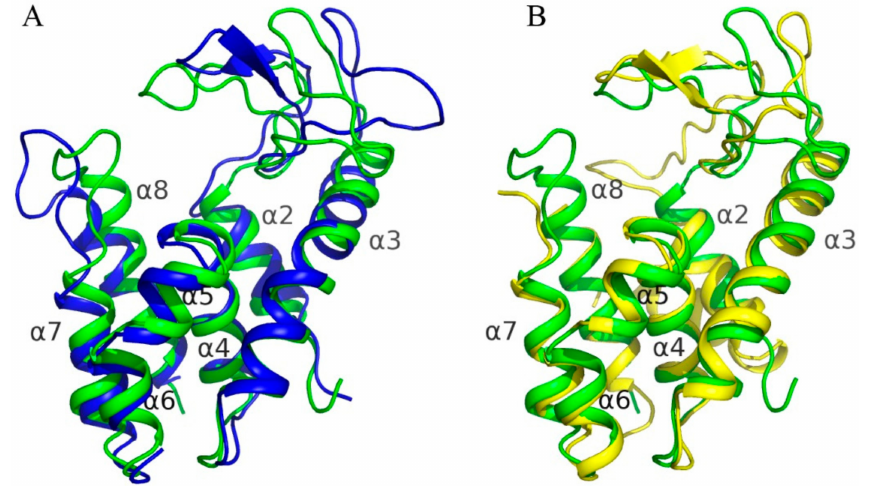
Figure 6. Superposition of AcLys to structures of homologue enzymes. AcLys is colored in green. Secondary structure elements were captioned in accordance to AcLys. ( A ) Superposition on P22 lysozyme (2ANV); ( B ) Superposition on full-length endolysin R21 from phage 21